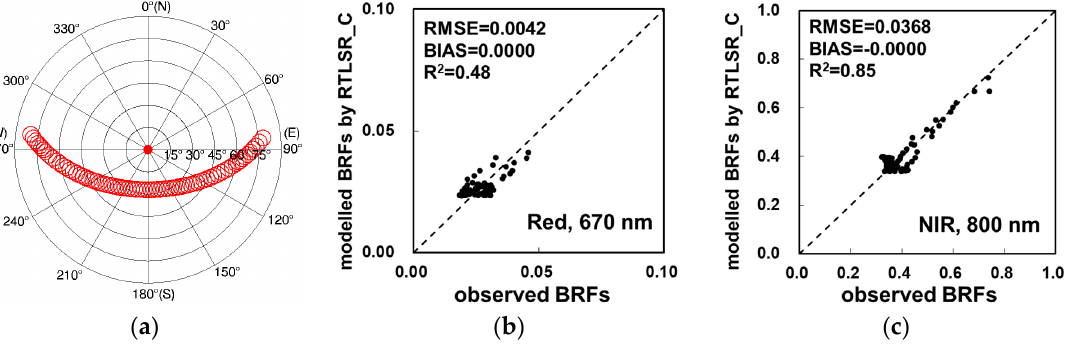
Figure 13. BRDF variances of the AHI-like daily time-series field measurements of nadir surface reflectances for maize. ( a ) The spatial distribution of the accumulated sun-viewing angles. ( b , c ) refers to the comparisons of reflectances between the observed and RTLSR_C-fitted values in the red and NIR bands,